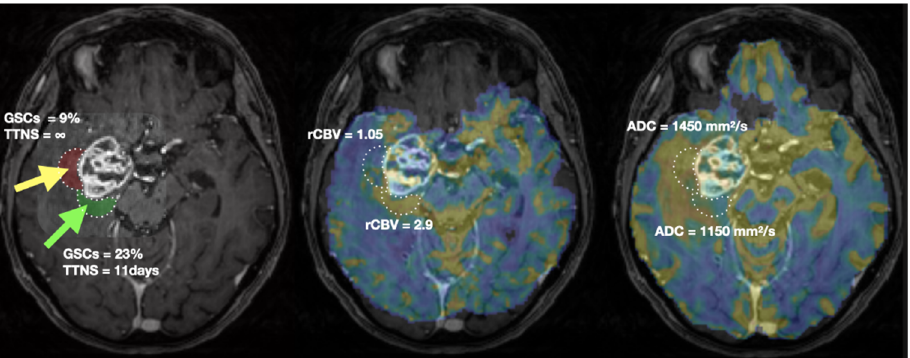
Figure 5. Biopsies location (green arrow: CNI>2, yellow arrow: CNI<2) and characterisation ( left ), rCBV ( middle ) and ADC ( right ) values in a representative patient. The two ROIs of 2040 mm 3 used to extract MRI metrics are shown in green and red on the T1CE image ( left ). TTNS: Time To NeuroSphere formation.